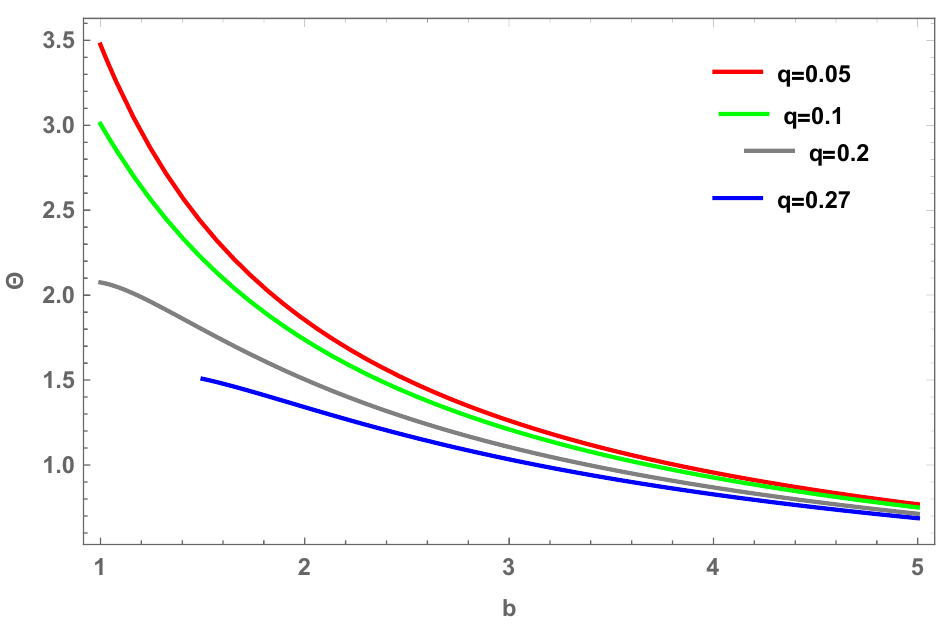
Figure 3. Relation between Θ and b of tidal-charged BH for positive values of q for M p = 1, M 5 = 0.5, = 10 − 1 for exaggeration of the M = 1 and ω e ω ∞